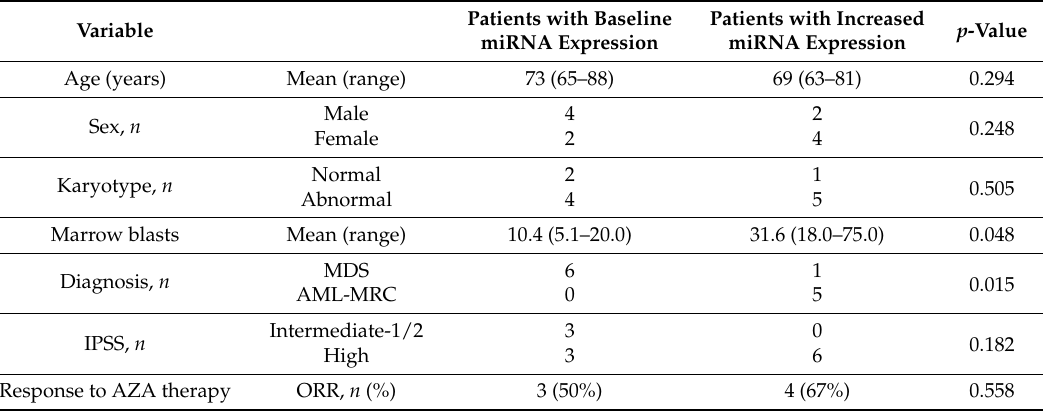
Table 1. Clinical characteristics of patients and their stratification according to expression activity in the DLK1–DIO3